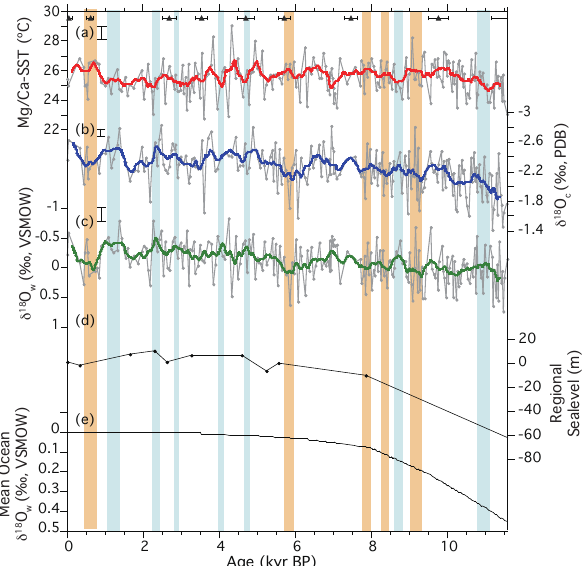
Figure 6. Results of reconstructions of temporal variations in (a) Mg / Ca-derived SST, (b) δ 18 O c , (c) δ 18 O w of core KY07-04- 01. Errors are represented as bars. Bold lines in (a) to (c) represent 300-year average. (d) Time series of regional sea-level record in the East China Sea (Saito et al., 1998). (e) Temporal changes in global mean ocean δ 18 O w (Waelbroeck et al., 2002). 14 C age con- trolling points of core KY07-04-01 are represented as triangles in the top part of the plot with 2 σ errors. Brown and blue bars repre- sent higher and lower δ 18 O w intervals for core KY07-04-01 (Kub- ota et al.,